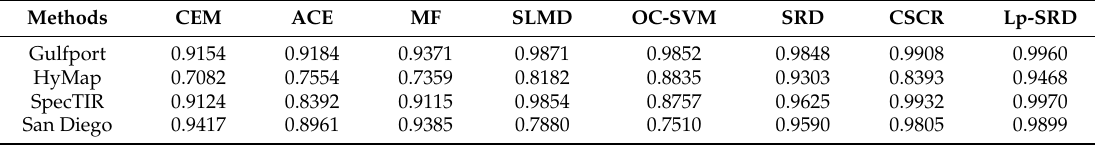
Figure 19. Detection performance using the San Diego dataset: ( a ) Statistical separability analysis. ( b ) ROC curves. Table 1. AUC values of different target detectors using four experimental datasets.